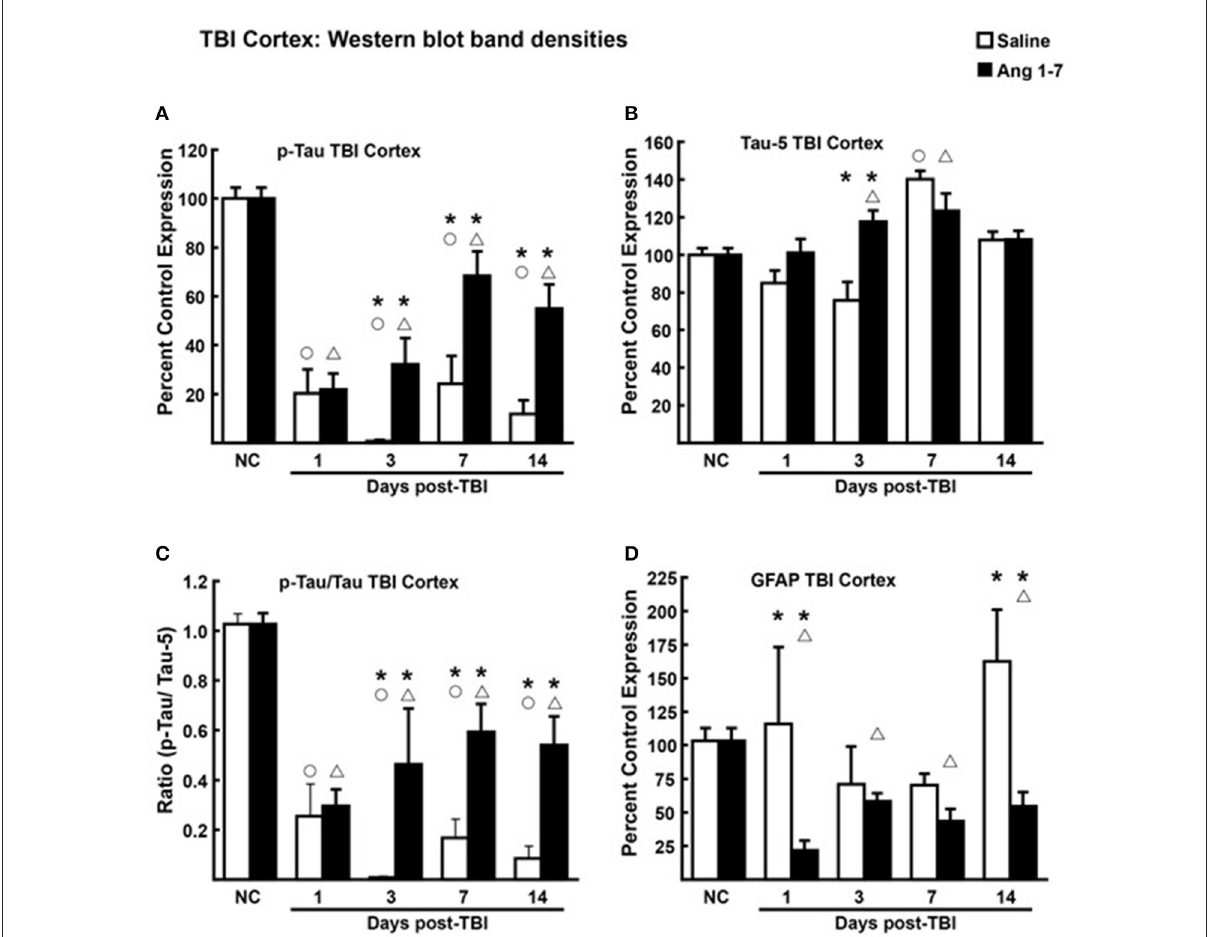
FIGURE6 Protein changes in ipsilateral cortex following TBI ( N = 3–4 mice/group). (A) Pooled protein densities of cortex from Western blot studies demonstrate a significant decrease for pTau on days 1, 3, 7, and 14 after a mTBI in both Ang-(1-7) (1 mg/kg, i.p. days 1–5) and saline treated animals. Yet, a significant difference was seen on days 3, 7, and 14 in Ang-(1-7) treated animals as compared to saline with less pTau expression. (B) There was a significant increase in Tau on day 7 but not on days 1, 3, or 14, Ang-(1-7) did have a significant effect in increasing overall Tau on day 7 but was no different to saline on the other days. (C) The pTau:Tau ratio is expressed relative to 1.0, the pre-TBI control value and demonstrated a significant difference on days 3, 7, and 14 between saline and Ang-(1-7) treatment. (D) GFAP was represented as Percent Control Expression for post-TBI days 1, 3, 7, 14. GFAP expression in cortex demonstrated a reverse-U-shaped curve with levels increasing on days 1 and 14 but decreasing on days 3 and 7. Ang-(1-7) demonstrated a significant decrease in GFAP on days 1 and 14 as compared to saline treatment. NC (normal control) is pre-TBI control protein levels standardized to a value of 100. “ ◦ ” indicates a statistically significant difference ( p < 0.05) in expression level or ratio between the selected post-TBI day and baseline for saline treated animals. “ 1 ” indicates a statistically significant difference ( p < 0.05) in expression level or ratio between the selected post-TBI day and baseline for Ang-(1-7) treated animals. “ * ” indicates a statistically significant difference ( p < 0.05) in expression level or ratio between the Ang-(1-7) and Saline treated groups for the selected post-TBI day ( N = 4